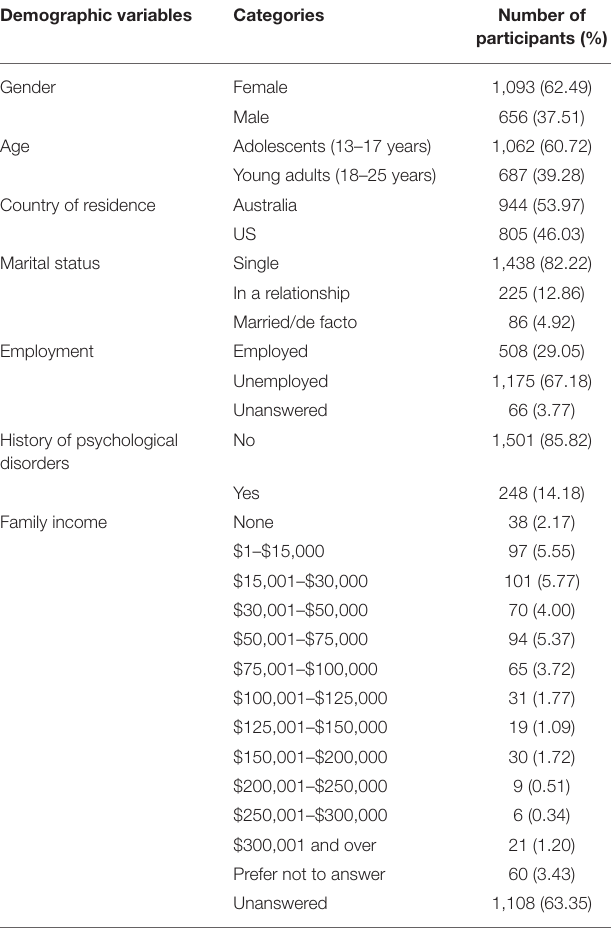
TABLE 1 | Number of participants by demographic